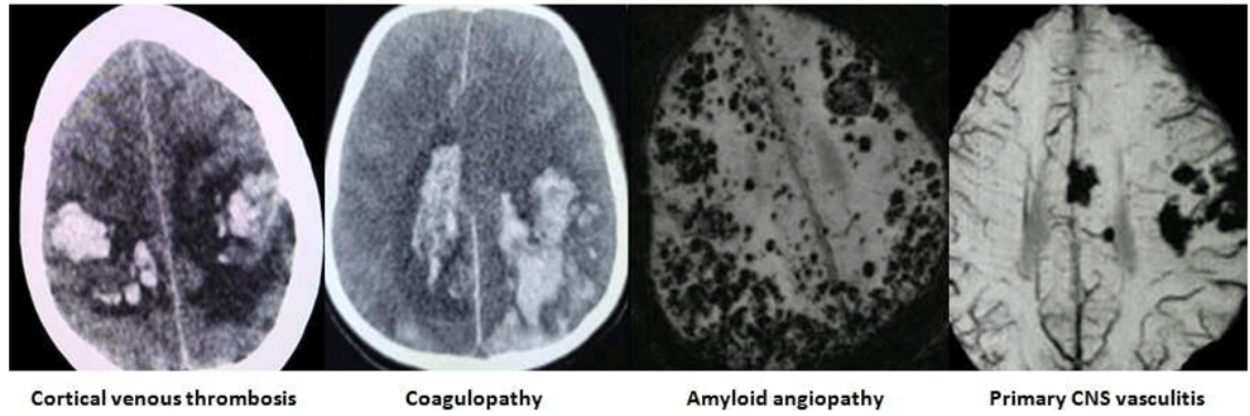
Figure 3. Miscellaneous etiological basis of spontaneous simultaneous multiple intracerebral hemorrhages. All images are original, deidentified, and of our patients themselves.